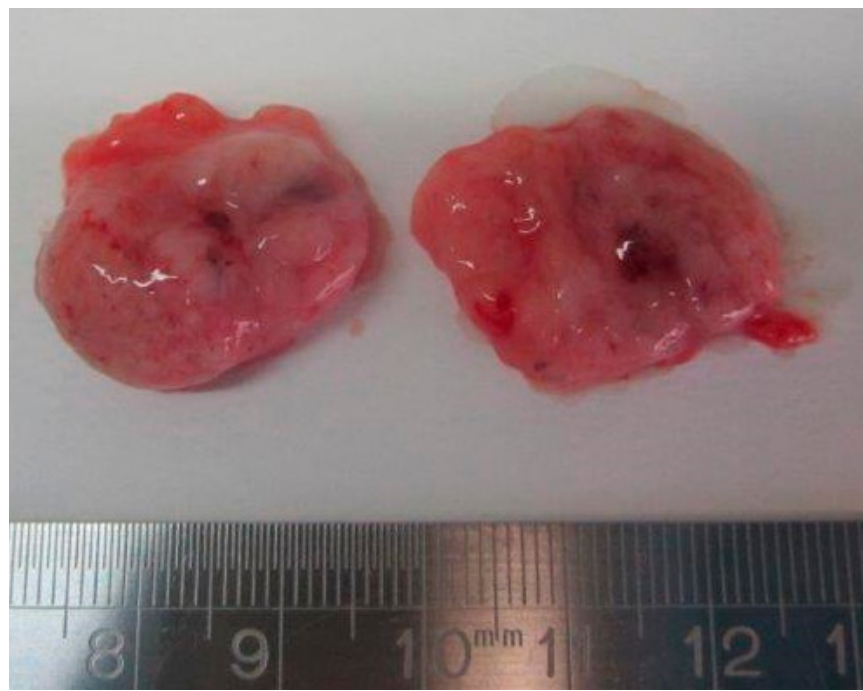
Figure 3. Dissected appearance of the teratoma: a pinkish solid, but soft nodule with cystic areas.